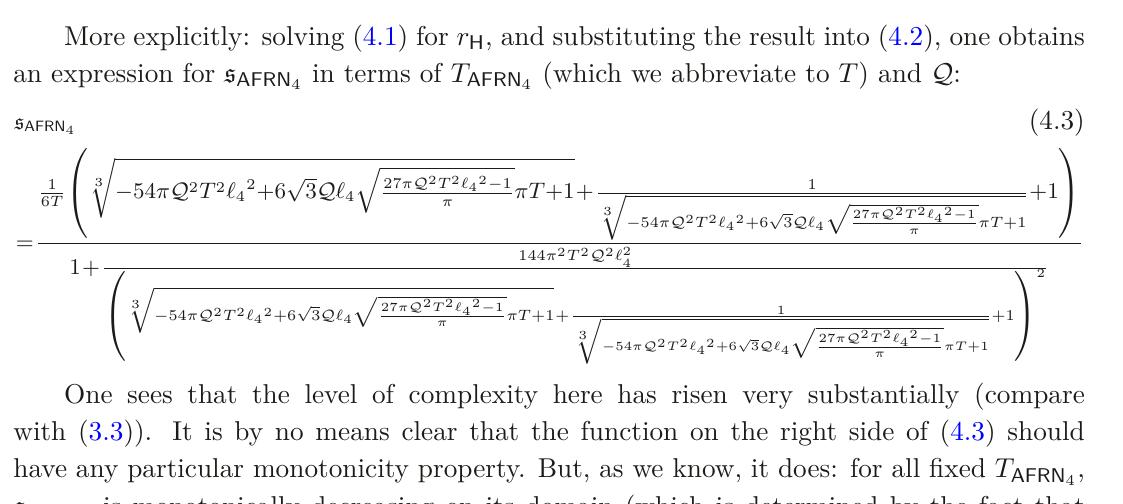
Figure 1 . Specific entropy of a four-dimensional asymptotically flat Reissner-Nordström black hole with fixed temperature 0.25 in Planck units, as a function of the